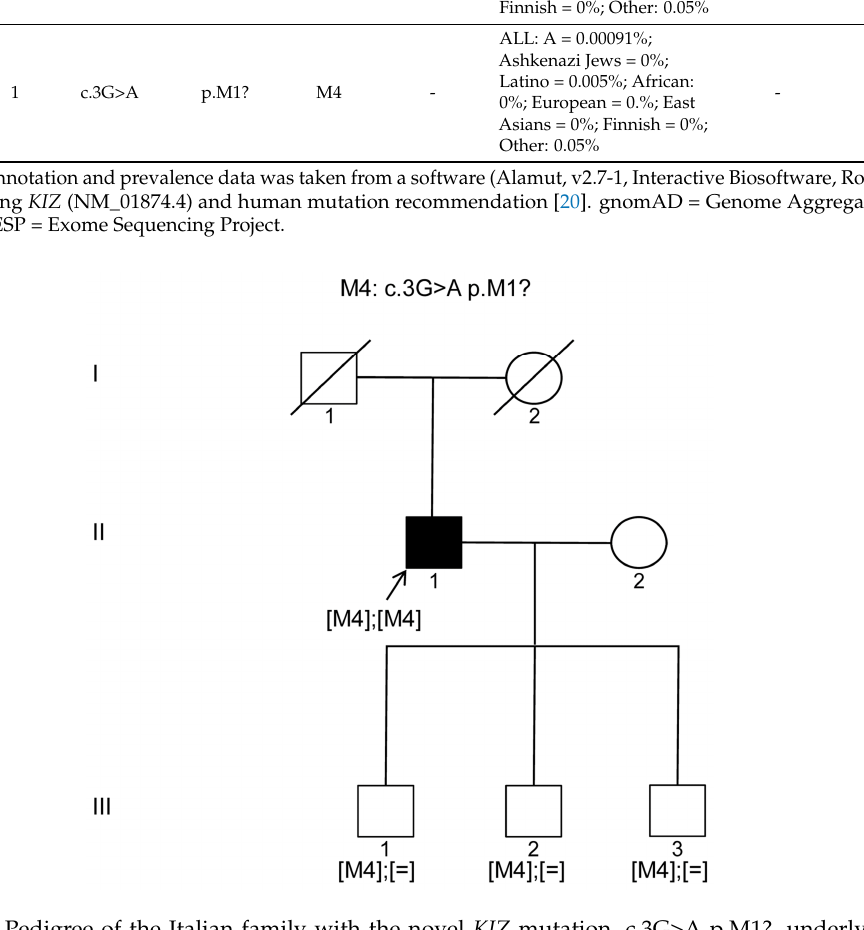
Figure 1. Pedigree of the Italian family with the novel KIZ mutation, c.3G>A p.M1?, underlying autosomal recessive rod-cone dystrophy. Shapes filled with black and white colors, respectively, represent affected and unaffected individuals. Squares and circles respectively indicate men and women. ↖ marks the index subject.